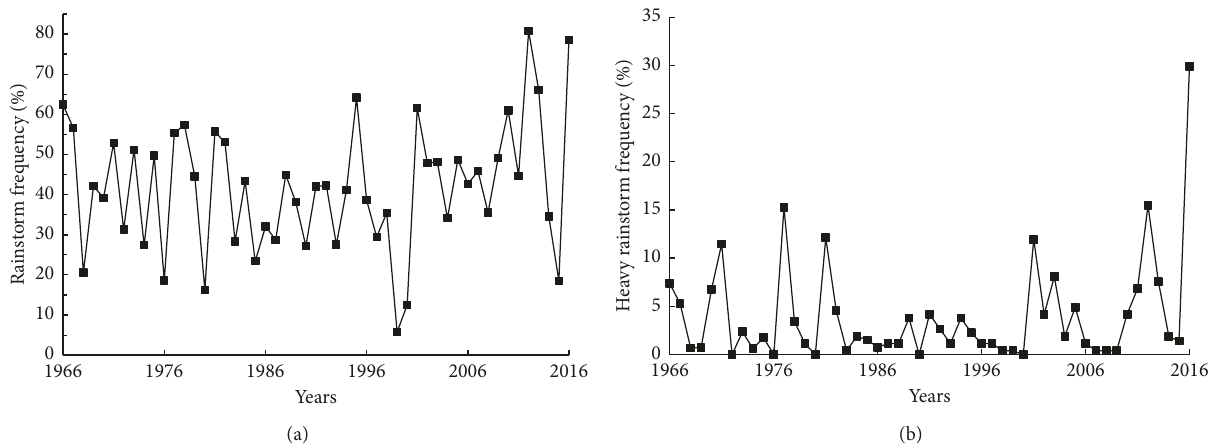
Figure 5: Time series of frequency of rainstorms (a) and heavy rainstorms (b) in the HLR from 1966 to 2016.